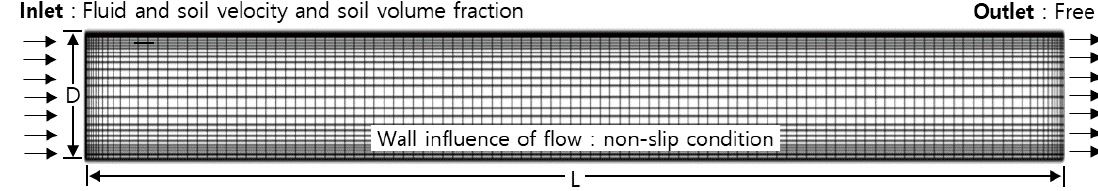
Figure 3. Mesh of a stormwater pipe and boundary conditions applied in this study [31,32].